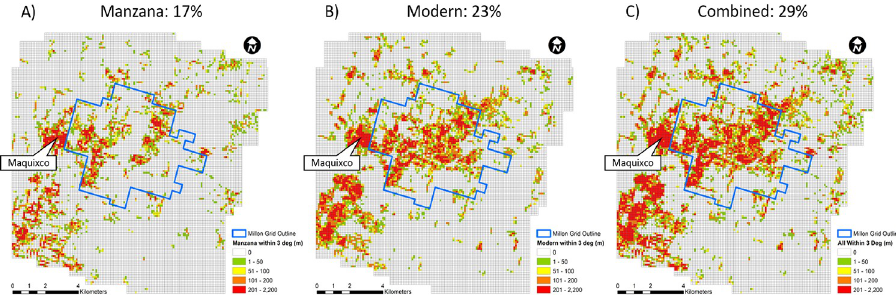
Fig 5. Distribution heat maps. A) Modern Property Alignment (Manzana boundaries), B) Modern Teotihuacan Alignment, and C) combined Teotihuacan Alignment features. Map displays total length for each 100m 2 grid and % of grids with values above 1. Map produced by T.